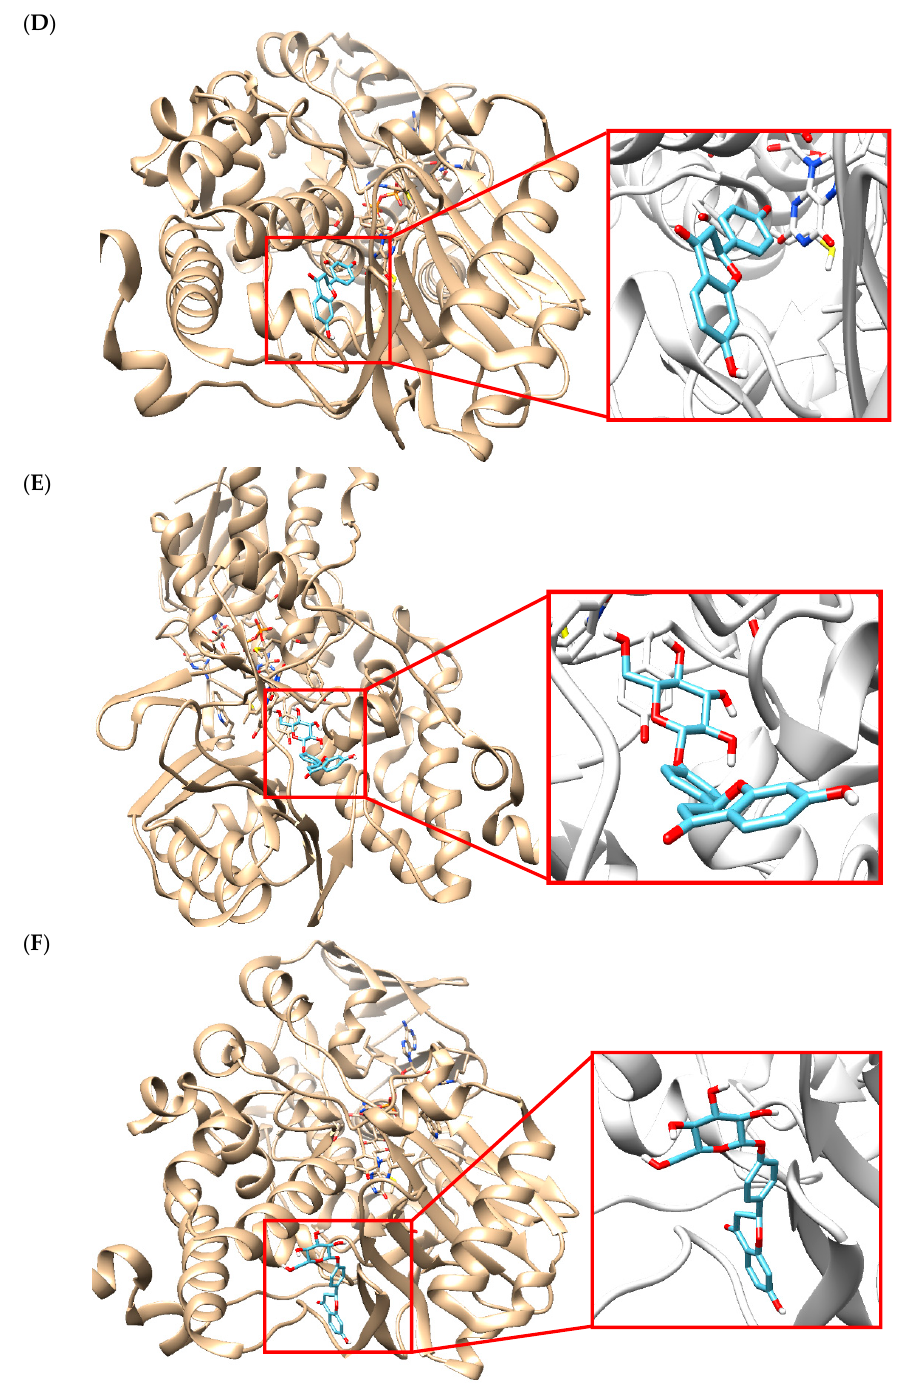
Figure 4. Docking simulations of GC with AChE ( A ) and BChE ( B ), LG with MAO-A ( C ) and MAO-B ( D ), and liquiritin with MAO-A ( E ) and MAO-B ( F ). AChE (1GQS), BChE (4TPK), MAO-A (2Z5X), and MAO-B (4A79) were subjected to docking analysis.